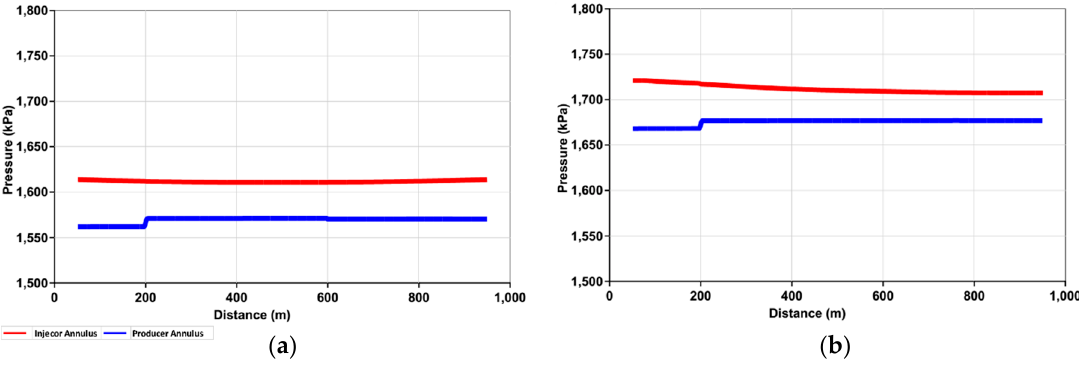
Figure 12. Annular pressure profiles. ( a ) Dual-string case; ( b ) optimized OCD case.